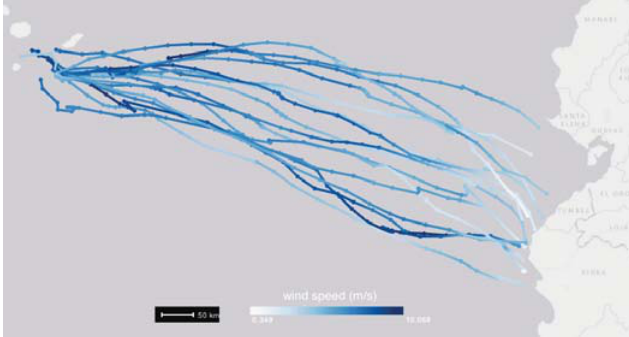
Figure 10: Nine Galapagos albatrosses flight between the Galapagos Islands (i.e., nesting site) and the Peruvian coast (i.e., foraging site). Tracks are annotated with wind speed (m/s): dark blue represents higher and light blue lower wind